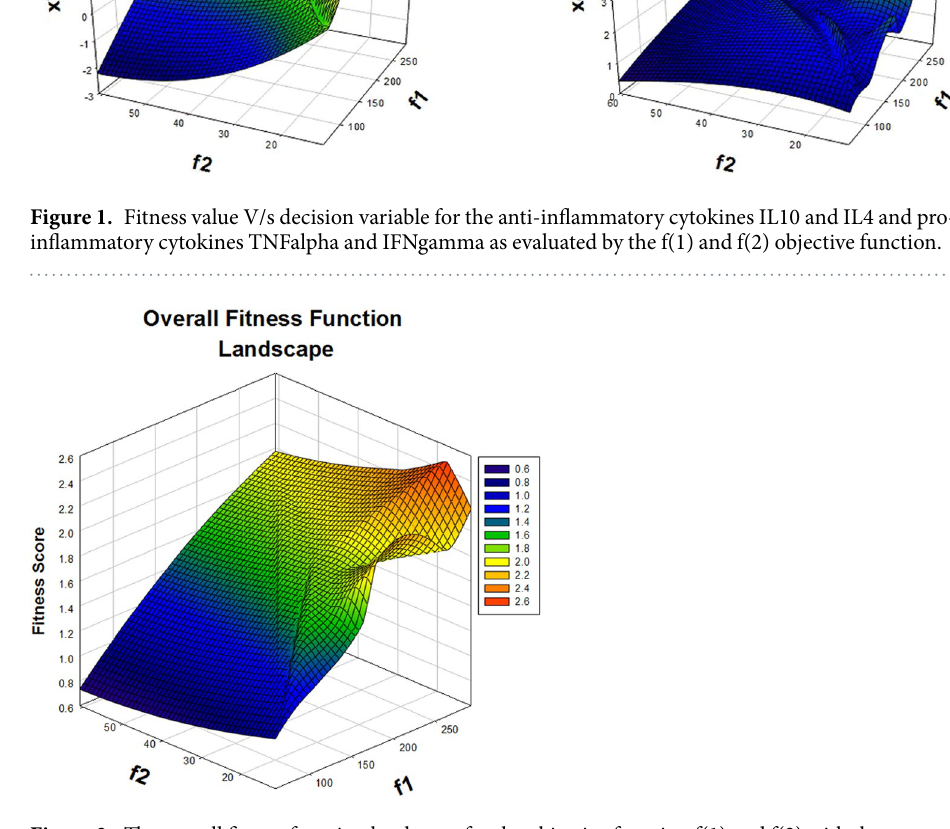
Figure 2. The overall fitness function landscape for the objective function f(1) and f(2) with the score colour scale for these objective